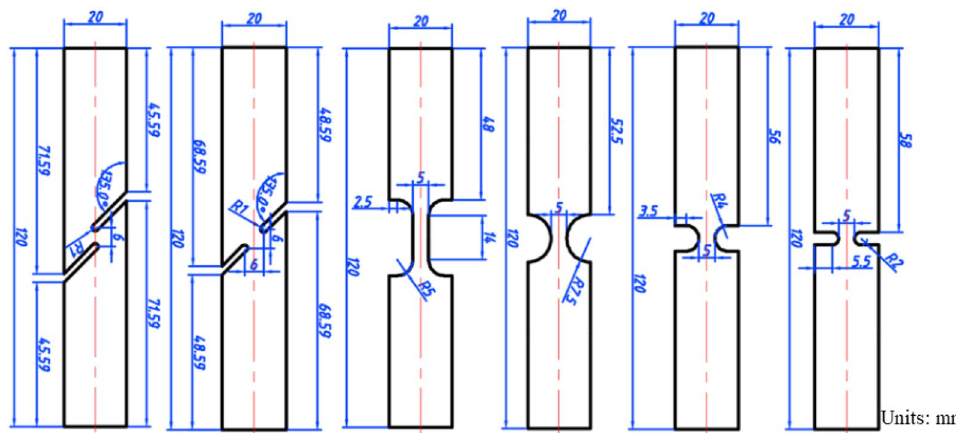
Figure 1 Specimens under different stress states